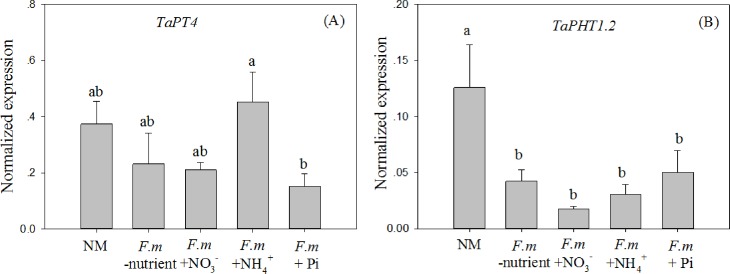
Relative expression of Pi transporter genes TaPT4 (A) and TaPHT1.2 (B) in experiment I. NM, non-mycorrhizal control; F.m-nutrient, wheat roots in RHC inoculated with the AM fungus Funneliformis mosseae, but no nutrients were added to HC; F.m +NO3-, +NH4+, and +Pi, wheat roots in RHC inoculated with the AM fungus F. mosseae, and 15NO3- (10 mM K15NO3), 15NH4+ (10 Mm (15NH4)2SO4), or Pi (1 mM KH2PO4) was added to HC, respectively. Values are means and standard errors (n = 4). Data with the same letter indicates no significant difference among treatments (P > 0.05).